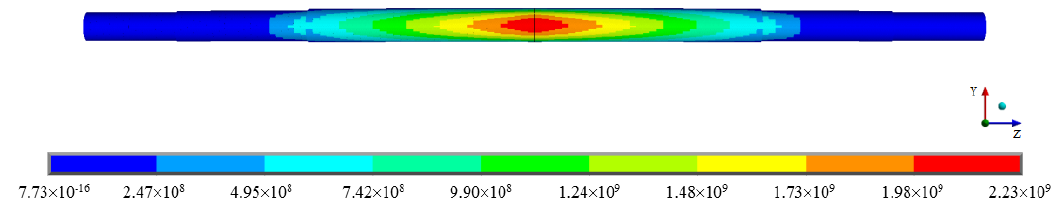
Figure 19. Equivalent stress contour of the main shaft under Q des (Unit: Pa).